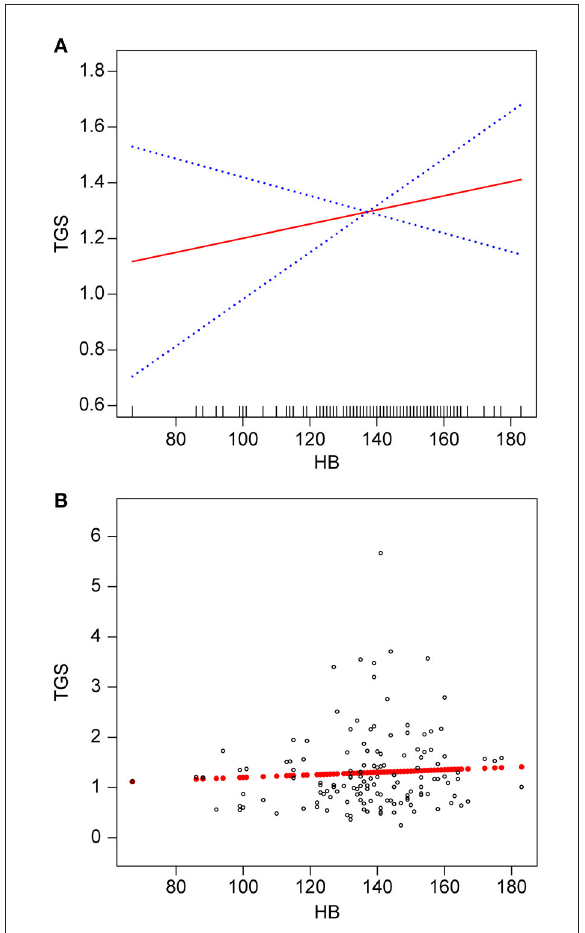
FIGURE4 Association between Hb (g/L) and TGs (mmol/L) in patients with ischemic MMD. (A) smooth fitted curve for Hb and TGs, (B) scatter plot for the distribution of Hb and TGs. The solid red line represents the smooth curve fit. The blue bands represent the 95% CI of the fit. The model was adjusted for age; smoking status; alcohol consumption; BMI; disease type; TC; HDL-C; LDL-C; VLDL-C; and